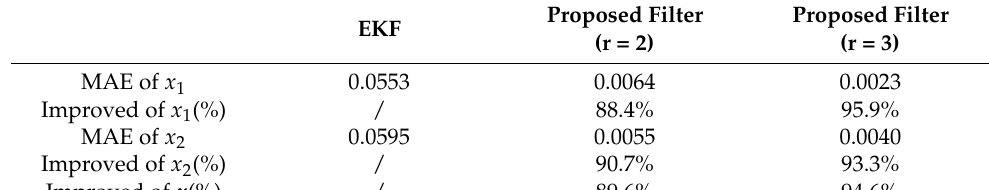
Figure 8. Estimation error of state 2. Table 2. Error comparison between the proposed filter and EKF in case 2.